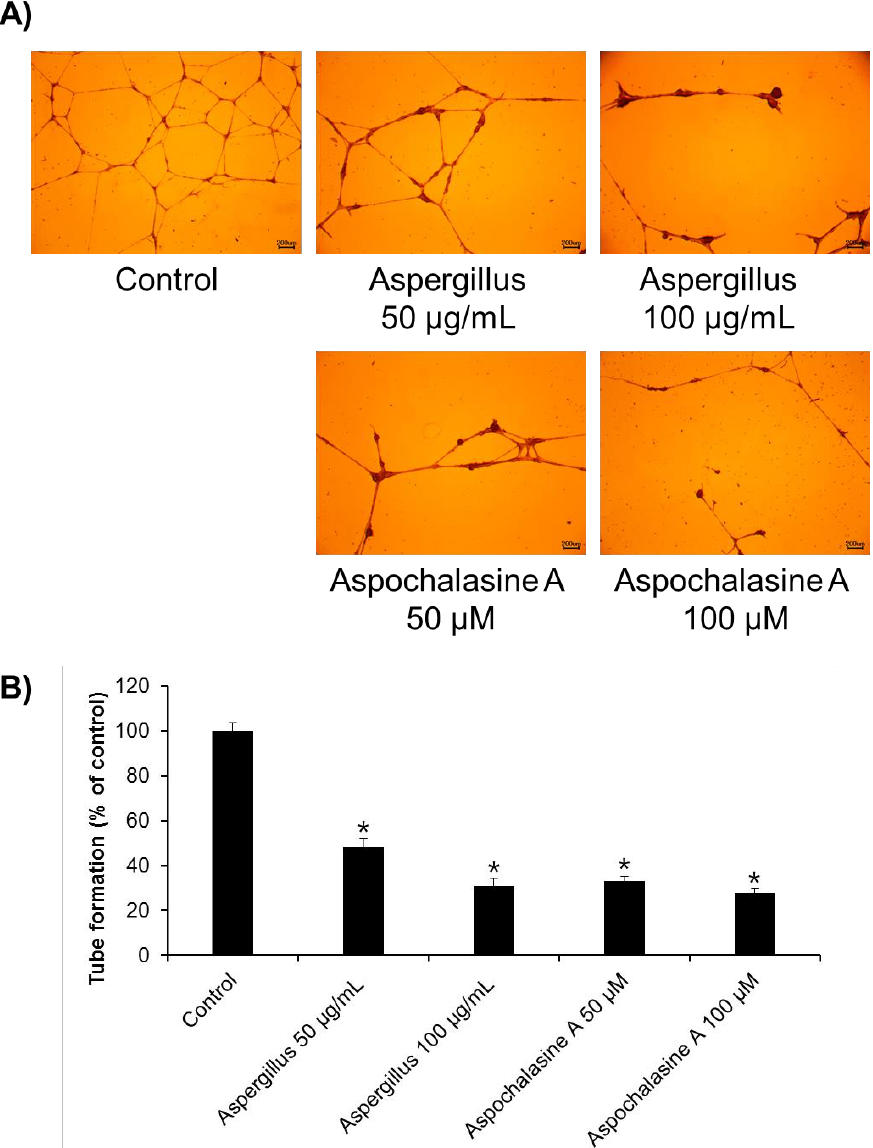
Figure 4. The effect of Aspergillus extract and aspochalasine A on HUVEC tube formation. ( A ) Representative images for tubule formation after treatment with the indicated concentrations of Aspergillus extract and aspochalasine A. ( B ) The length of the tubes was measured using the ImageJ software, and is represented as the percentage of tubule formation compared to the control. Data are expressed as mean ± SEM. Similar results were obtained in three independent experiments; * p < 0.05 compared to the control value.